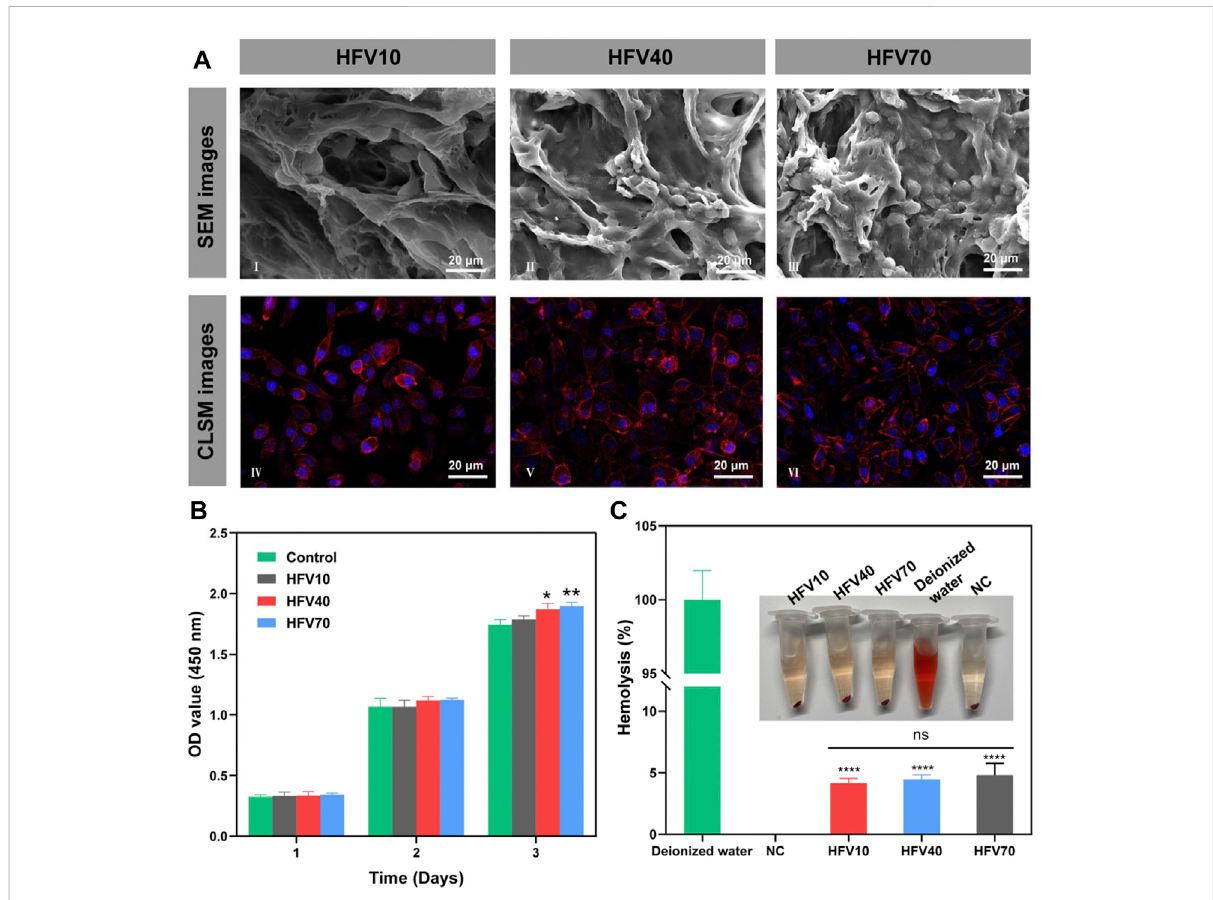
FIGURE 3 Evaluation of cell compatibility and blood compatibility of HFVs in vitro . (A) SEM (I – III) and confocal microscopic images (IV – VI) of L929 cells cultured on HFVs after 3 days. (B) CCK8 results of L929 cells cultured in extracts from HFVs for 1, 2, and 3 days. (C) Macro photographs of the hemolysis test and the corresponding hemolysis percentage. * p < 0.05; ** p < 0.01; **** p < 0.0001, in comparison with the control